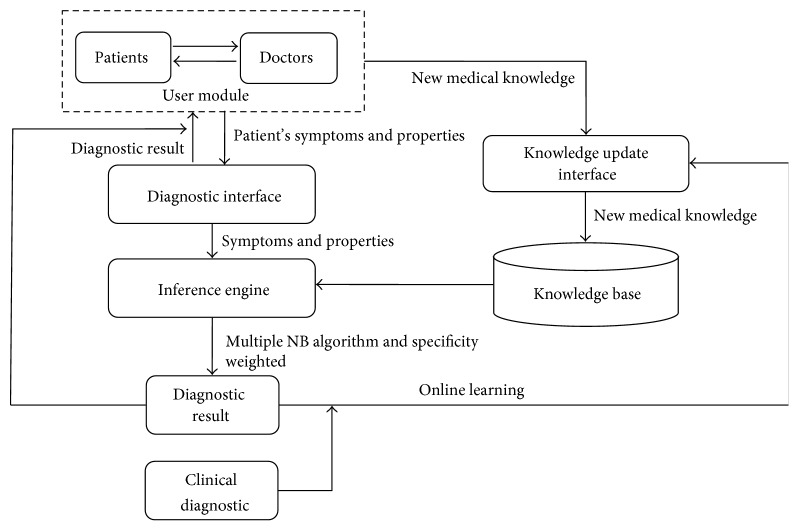
System framework.